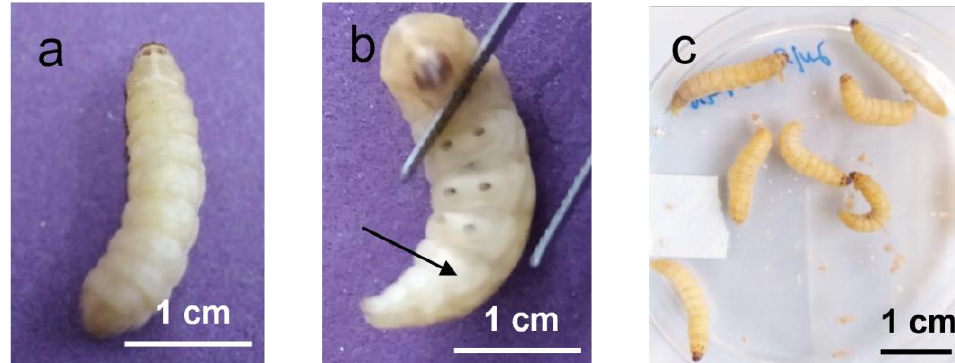
Figure 1. ( a ) Dorsal and ( b ) ventral views of Galleria mellonella larva at the last instar stage. The larva is divided into a head, a thorax with three segments, and an abdomen with 10 segments. The segment with the last proleg (arrow) is the fifth, counting from the anal segment with two non-visible anal prolegs; ( c ) Several larvae within a petri dish (original).